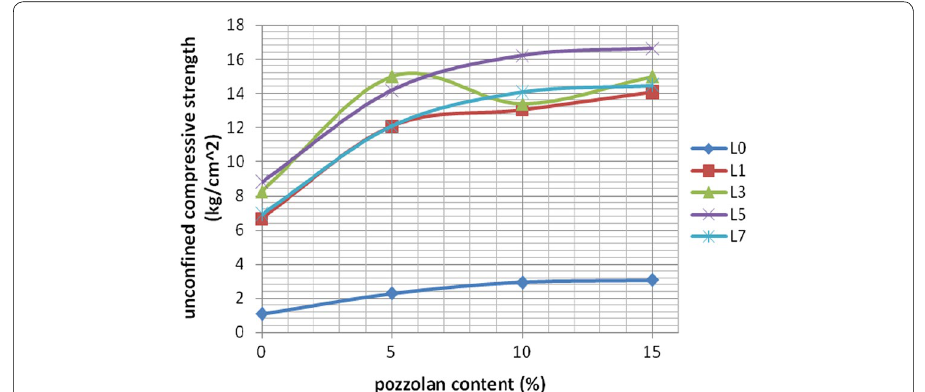
Fig. 6 Effects of pozzolan content on compressive strength of samples having different lime